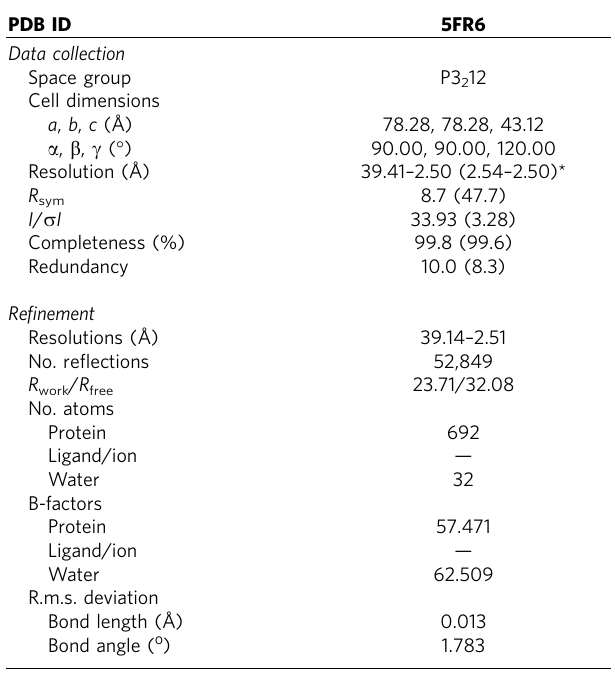
Table 1 | Crystallographic refinement statistics for BMI1 UBL